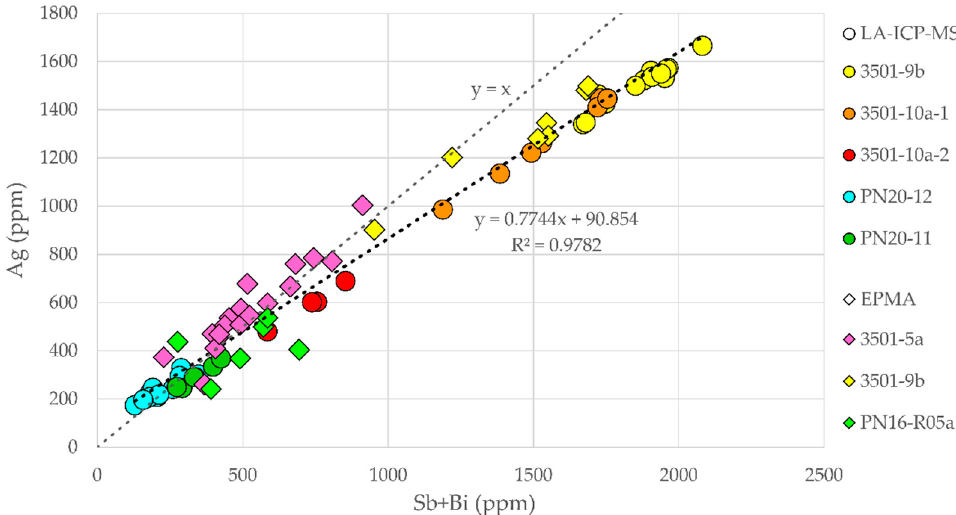
Figure 7. Ag versus Sb + Bi plot for trace elements in galena from MP samples (3501-10a-1 and 3501-10a-2 correspond, respectively, to galena from zone 1 and 2 on Figure 3b) and PN samples. Circles and diamonds represent LA-ICP-MS and EPMA analyses, respectively. The correlation line was drawn using all the dataset; the correlation coefficient is given by R².